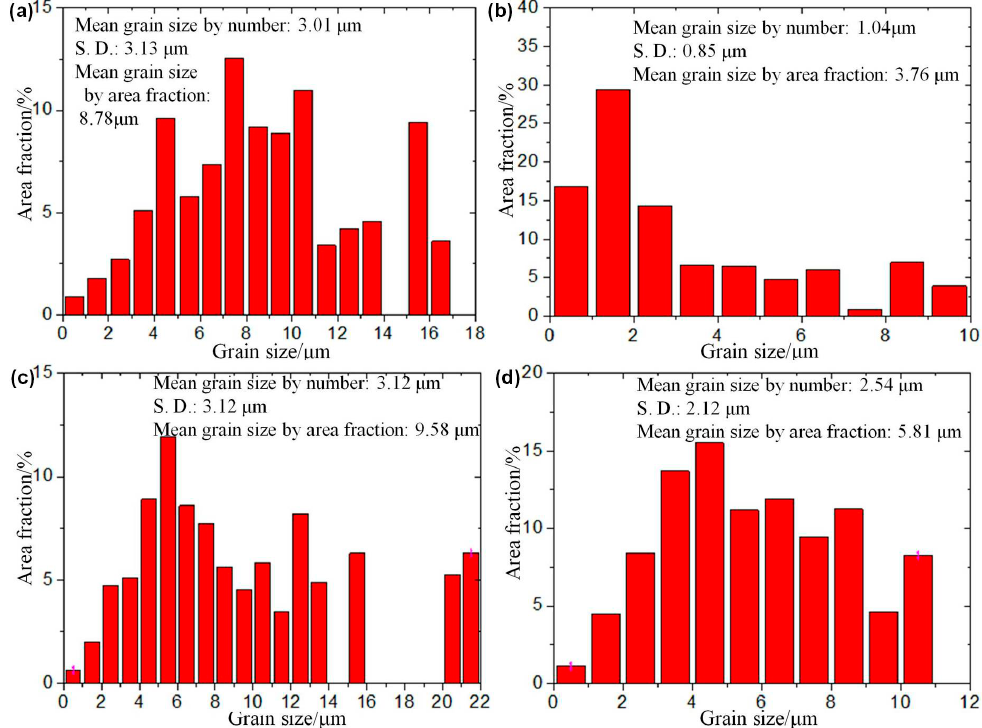
Figure 8. Histogram of γ grain size of the alloy after compression deformation under 1000 °C/10 − 2 s − 1 / ε = 0.11 ( a ), 1000 °C/10 − 2 s − 1 / ε = 0.36 ( b ), 1000 °C/10 − 4 s − 1 / ε = 0.11 ( c ) and 1000 °C/10 − 4 s − 1 / ε = 0.36 ( d ).